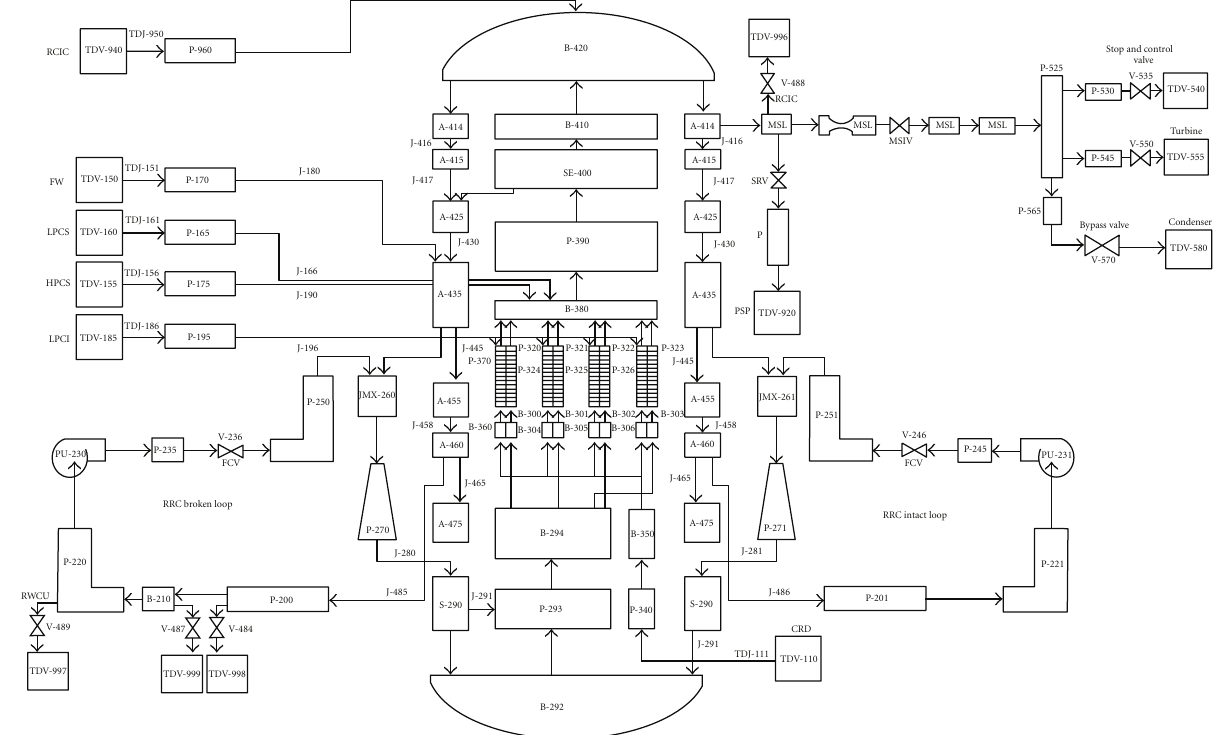
Figure 3: SCADAP/RELAP5 Laguna Verde Nuclear Power Plant model